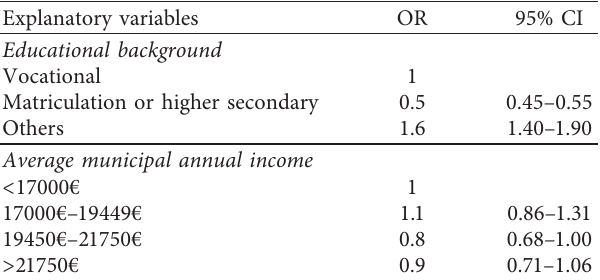
Table 2: Association between dental caries experience (DT > 0 vs. DT ≥ 1) and educational background and average municipal in- come among the Finnish